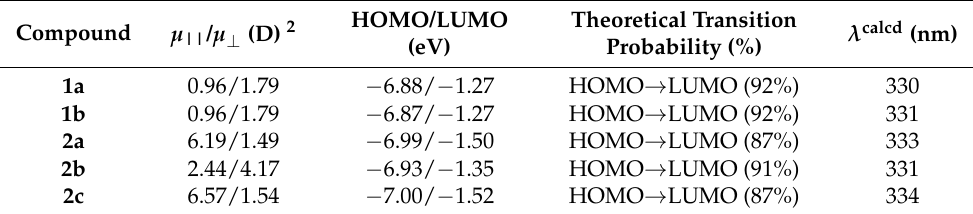
Table 1. Theoretical data obtained from quantum chemical calculations 1 . Compound